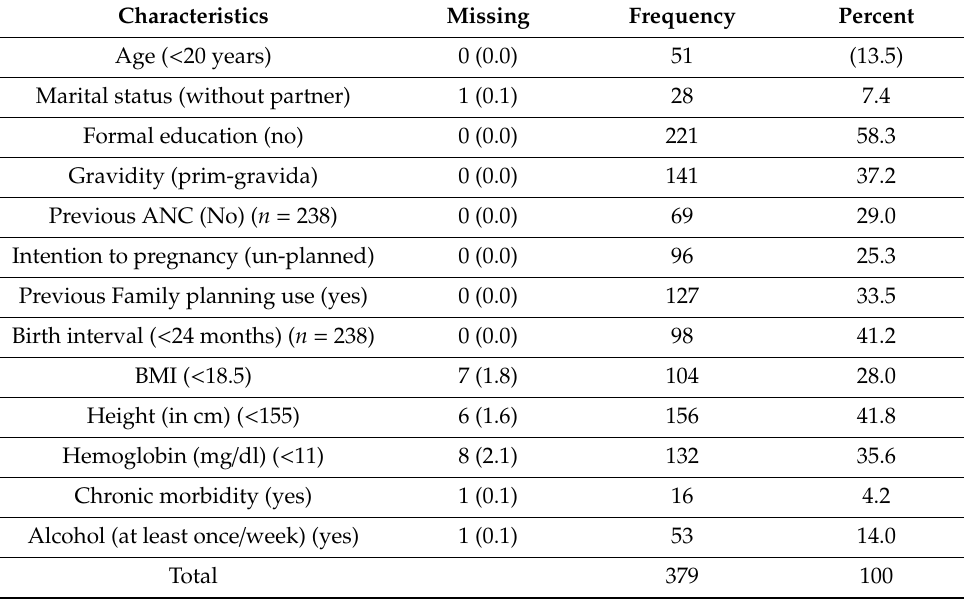
Table 1. Baseline demographic, obstetric, and clinical characteristics of pregnant women who were enrolled in the Butajira Nutrition, Mental health and Pregnancy (BUNMAP) project, south Ethiopia, 2016–2019 ( n =